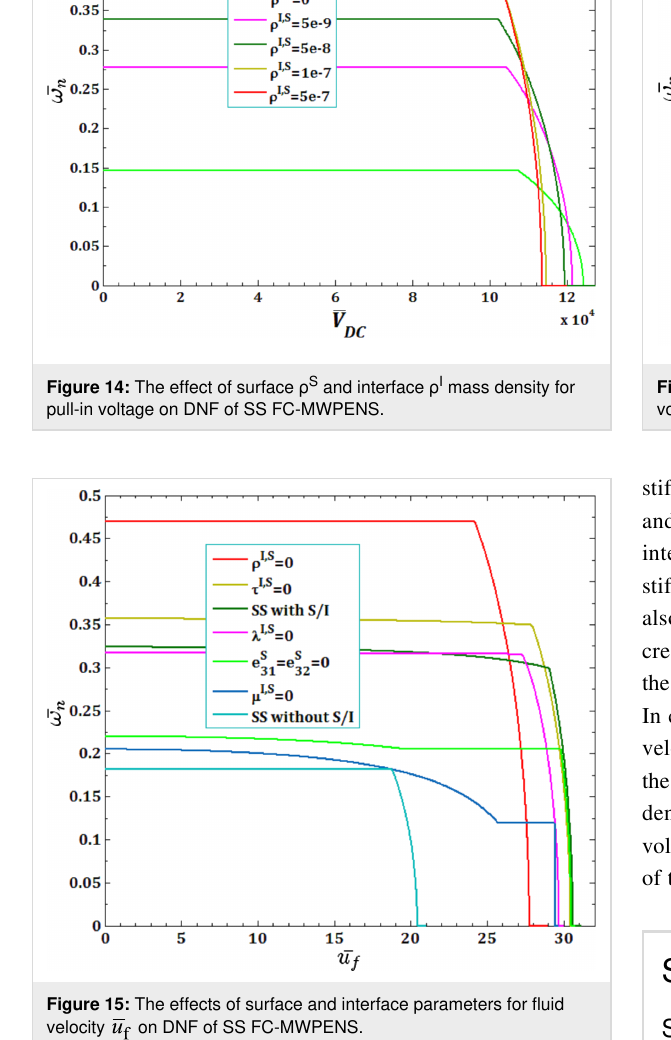
Figure 15: The effects of surface and interface parameters for fluid velocity on DNF of SS FC-MWPENS.